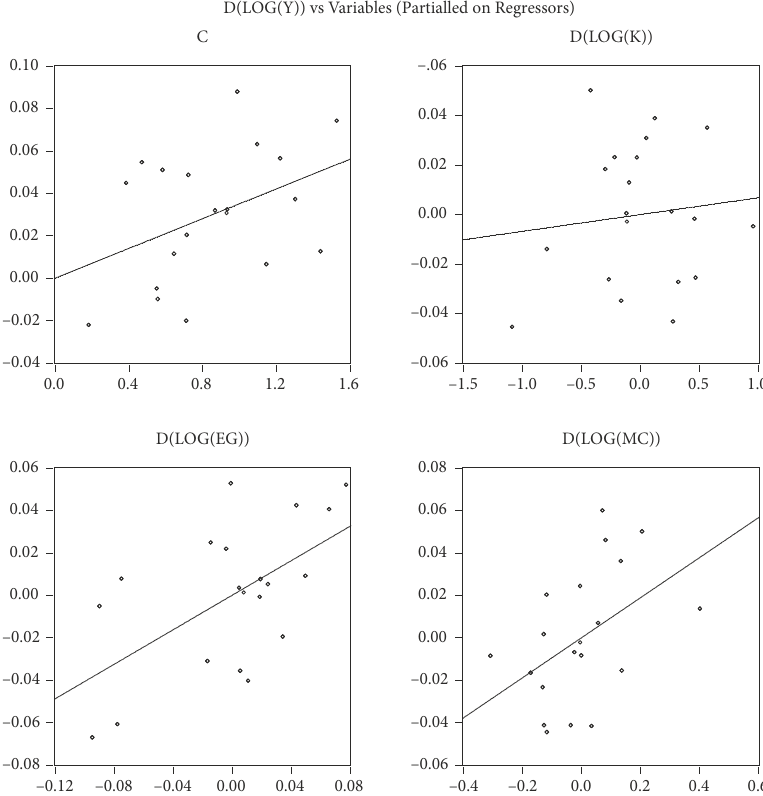
Figure 7. Leverage plots for Equation (9) (source: authors’ own